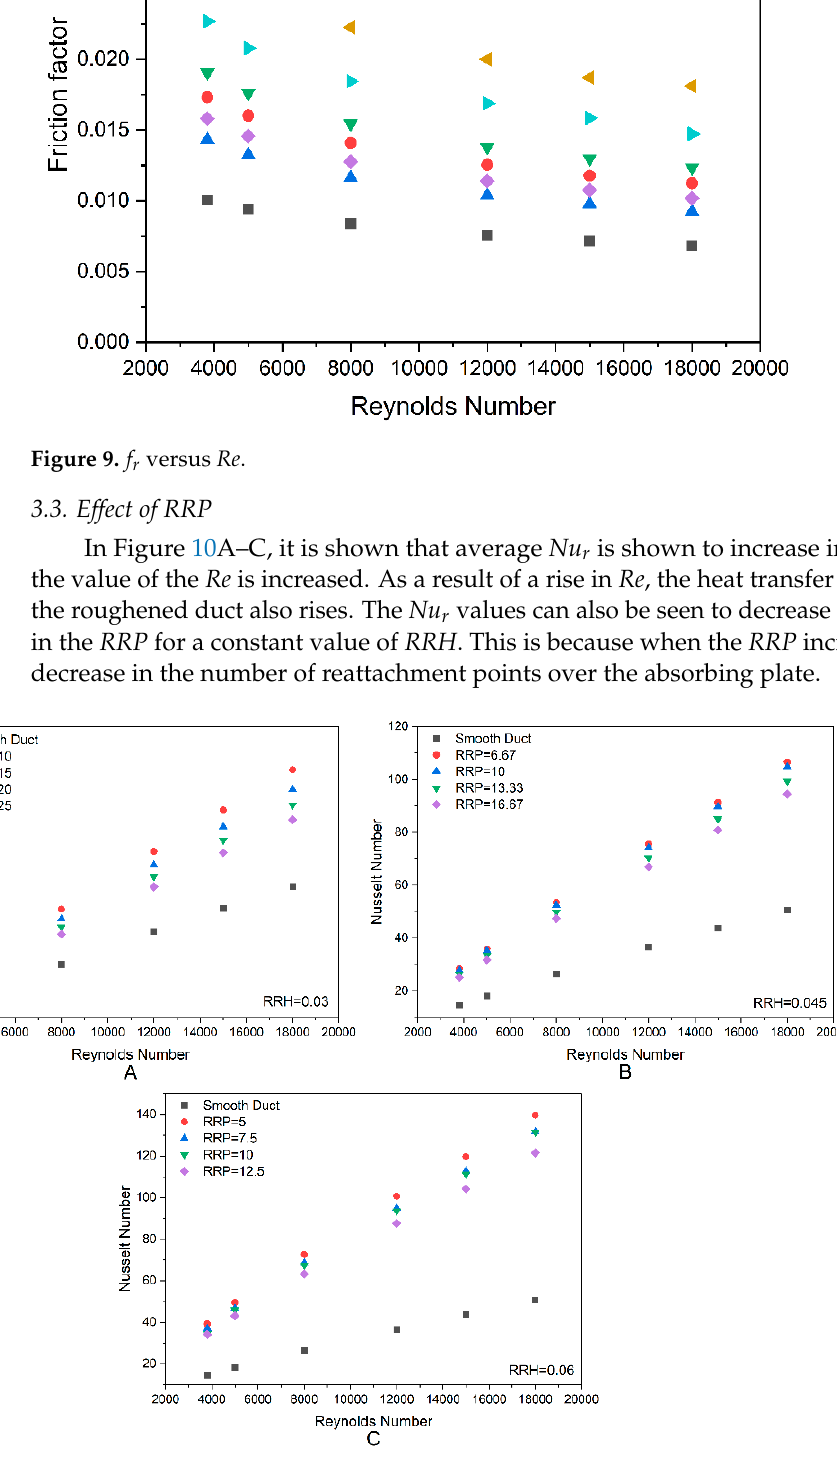
Figure 11. Nu r versus RRP for ( A ) RRH = 0.03, ( B ) RRH = 0.045, and ( C ) RRH = 0.06. In Figure 12A–C, it is evident that the f r decreases in all the cases with an increasing Re value, as expected based on the suppression of the viscous sub-layer. The f r values can also be found to decrease as the RRP is increased for a fixed value in terms of RRH due to a decreased number of interruptions in the flow path that is caused by the greater RRP . This occurs as a result of the fact that the duct of the SAH has fewer semi-circular sectioned ribs at a greater RRP , which ultimately leads to reduced flow resistance within the duct.